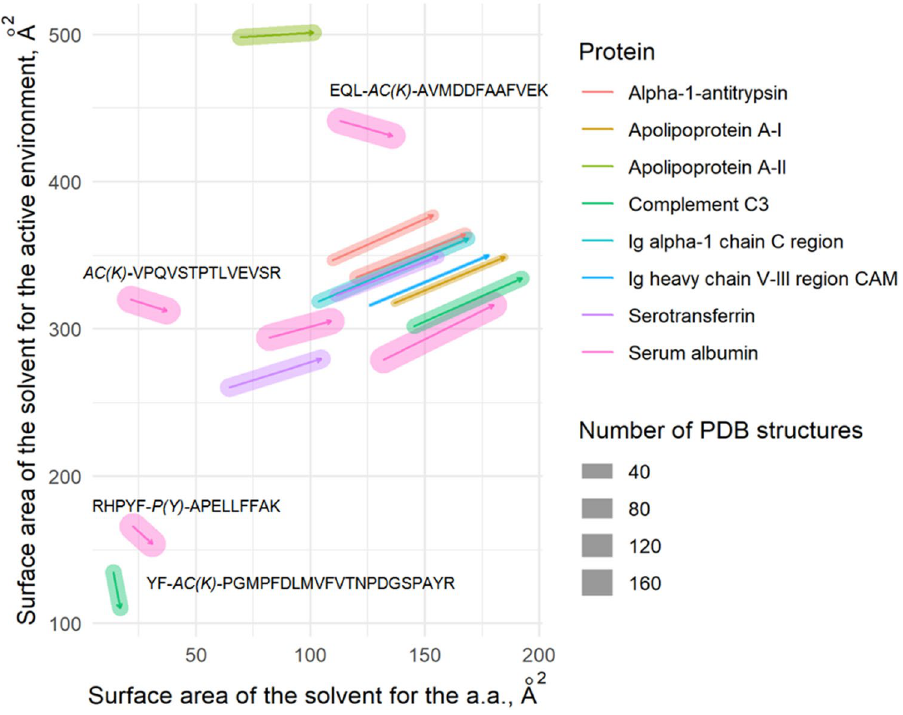
Figure 3. Variation of the total solvent-accessible area (in square angstroms; Å 2 ) of active environment after modification of amino acid residue (mounting of PTM). The modified proteins found in plasma samples of patients with breast cancer and ovarian cancer are color-coded. The number of PDB matched structures used for the analysis are designated by bar